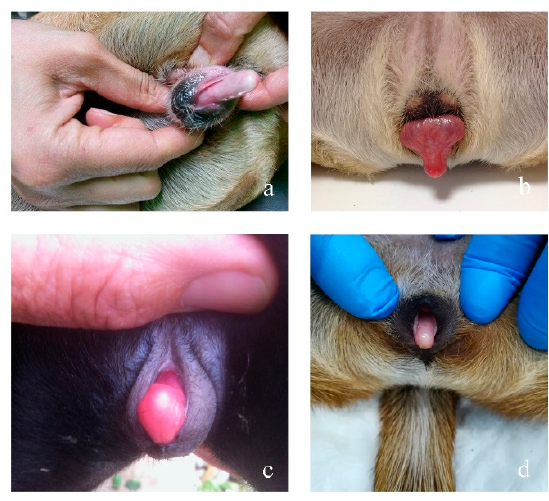
Figure 1. Abnormal clitoris (Megaclitoris) in the four analyzed cases: ( a ) Case 1; ( b ) Case 2; ( c ) Case 3; ( d ) Case 4.